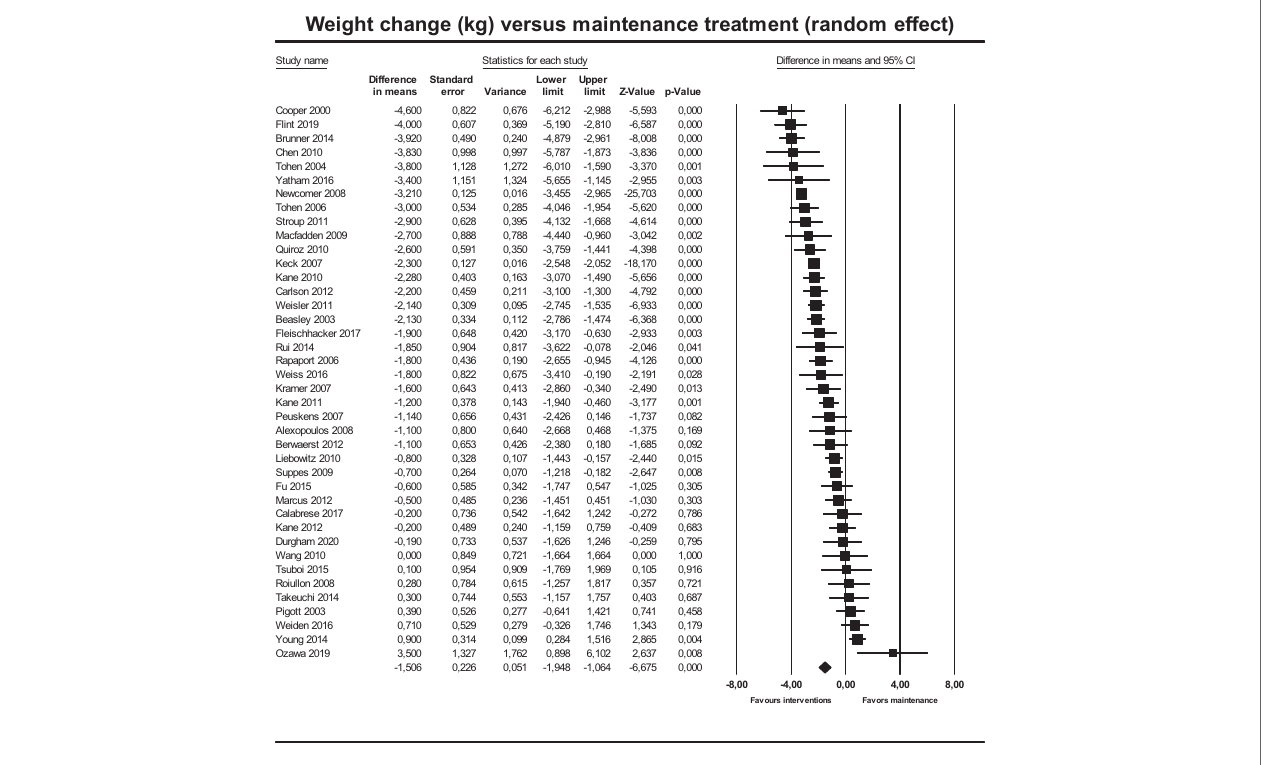
FIGURE 2 | Forest plot showing results from studies comparing maintenaince treatment to dose reduction, switch or discontinuation.